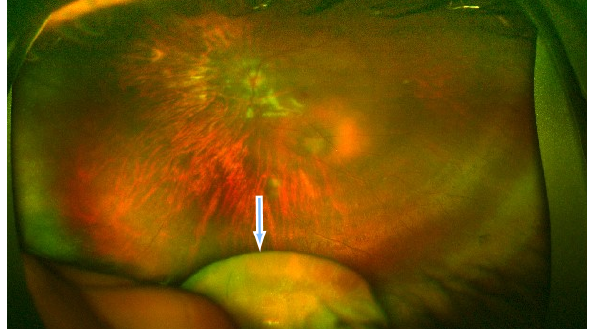
Figure 1: Fundus photograph of the left eye with the lens in the vitreous cavity